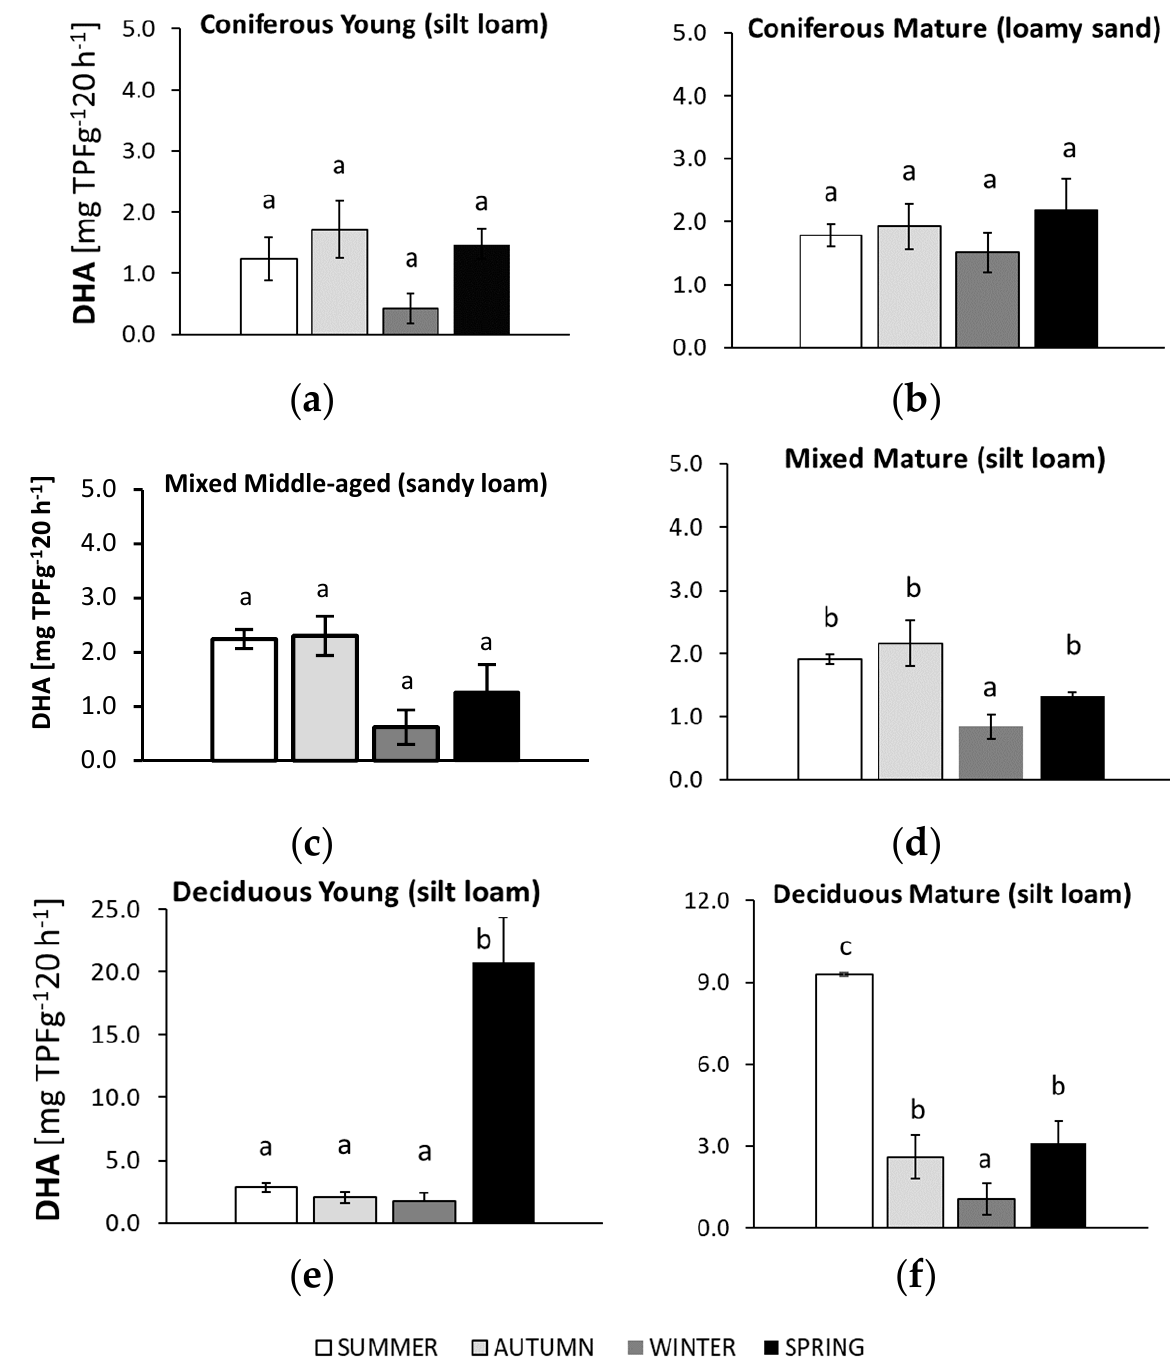
Figure 6. Dehydrogenase activity (DHA) in soil samples collected in summer, autumn, winter, and spring from different forests (average values ± standard deviation; n = 3). ( a ) Coniferous Young (silt loam); ( b ) Coniferous Mature (loam sand); ( c ) Mixed Middle-aged (sandy loam); ( d ) Mixed Mature (silt loam); ( e ) Deciduous Young (silt loam); ( f ) Deciduous Mature (silt loam). Different letters indicate significant differences (a non-parametric Kruskal–Wallis test, p < 0.05, was carried out separately for each season and for each forest).